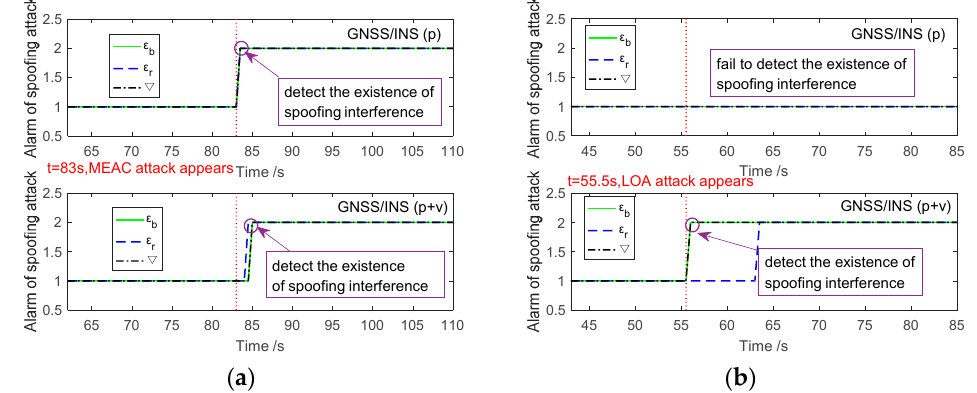
Figure 8. The detection of spoofing attack based on the IMU error compensation norms under MEAC attack ( a ) and LOA attack ( b ).